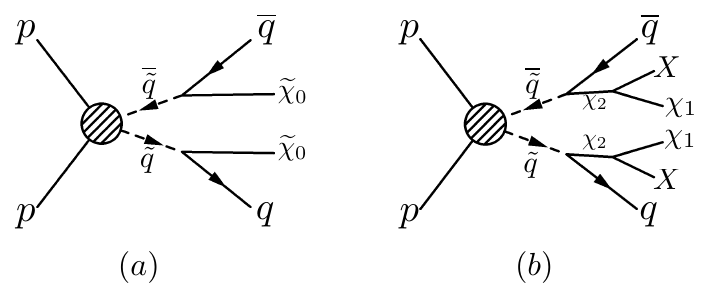
Figure 10 . An example of a simpli(cid:12)ed SUSY model diagram showing the direct production of light (cid:13)avour squark pairs decaying to two jets plus =E T (~ q ~ q framework the decay of ~ q q ~ (cid:31) 0 is assumed to be prompt. In b) we show a potential extension of 1 ! this simpli(cid:12)ed SUSY model to feature displaced signature. Here the neutralino is replaced with the long-lived fermion ~ (cid:31) 0 (cid:31) 2 , which may then decay to SM states X and (cid:31) 1 1 !